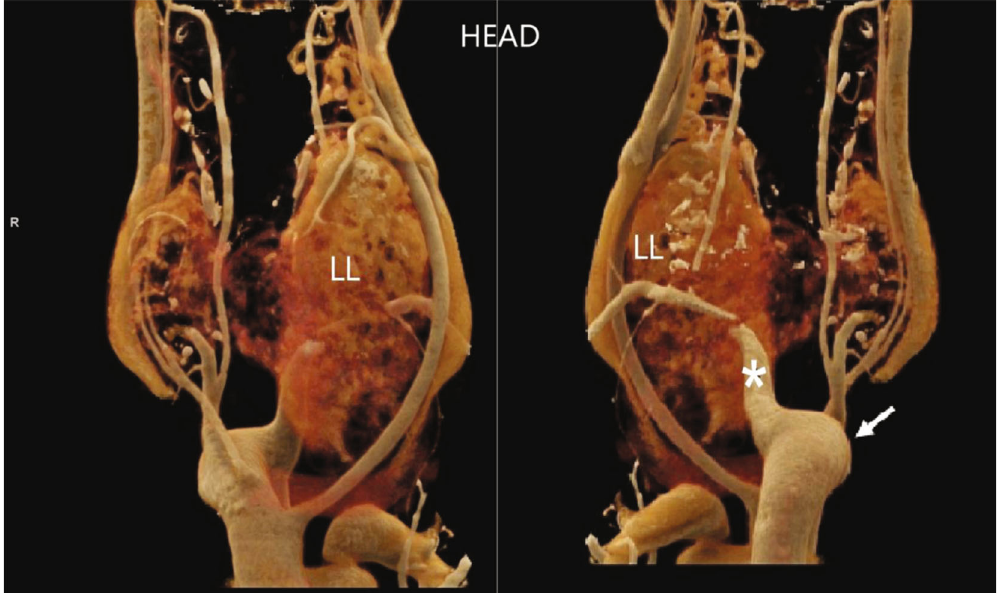
Figure 1: CT scan three-dimensional reconstruction. Frontal and posterior views of the cervical region, showing the volumetric increase in the thyroid, pronounced on the left lobe (LL), and evidencing the presence of the aortic arch on the right side (arrow), with left subclavian artery with retroesophageal path (asterisk).